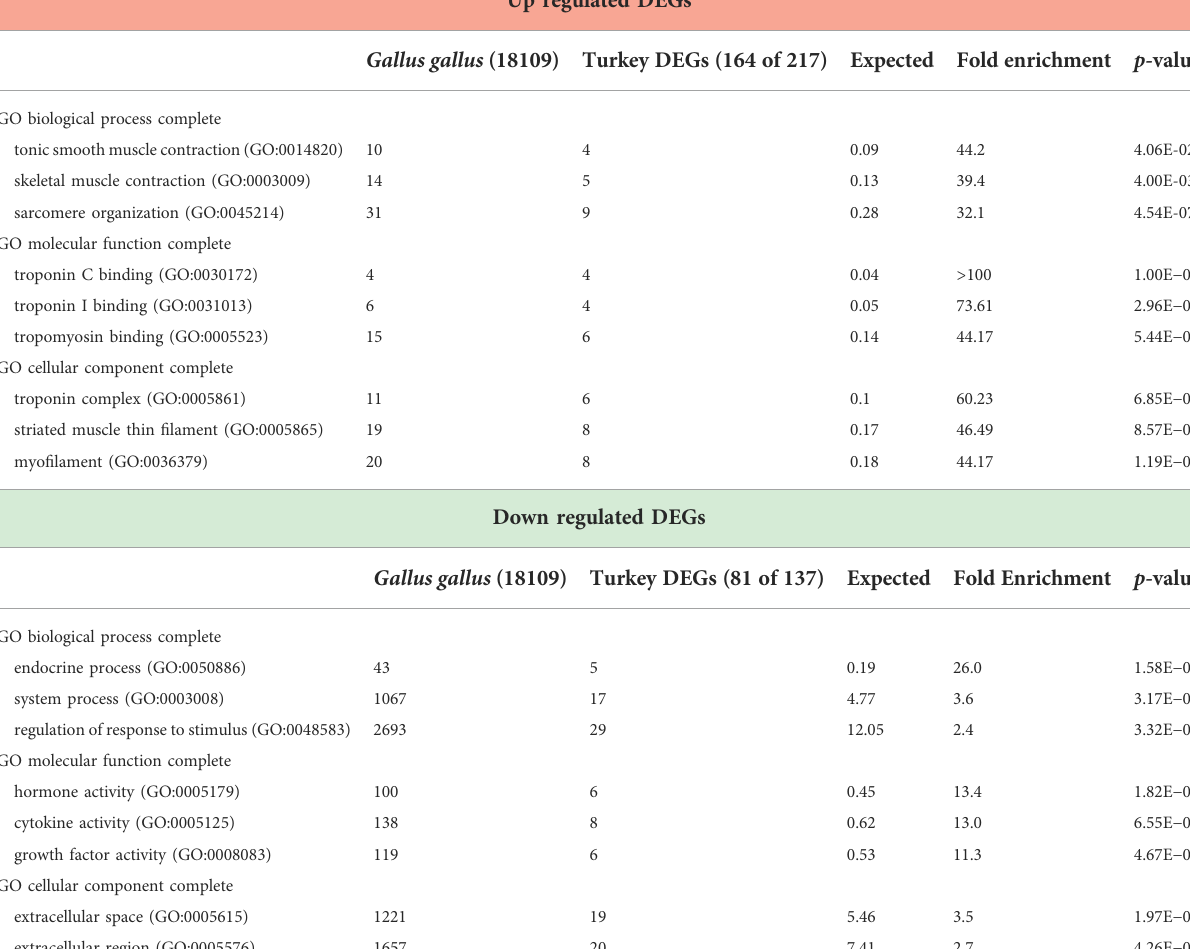
TABLE 3 PANTHER Overrepresentation test of 354 DEGs in the RBC2 line temperature comparison (43 ° C vs. 38 ° C) after 72 h of proliferation. Shown are the three gene ontology categories with the greatest fold enrichment in each category for the up and down-regulated genes a . Up regulated